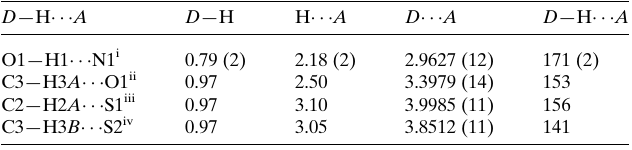
Table 3 Hydrogen-bond geometry (A˚ , (cid:3) ) for the RT structure.